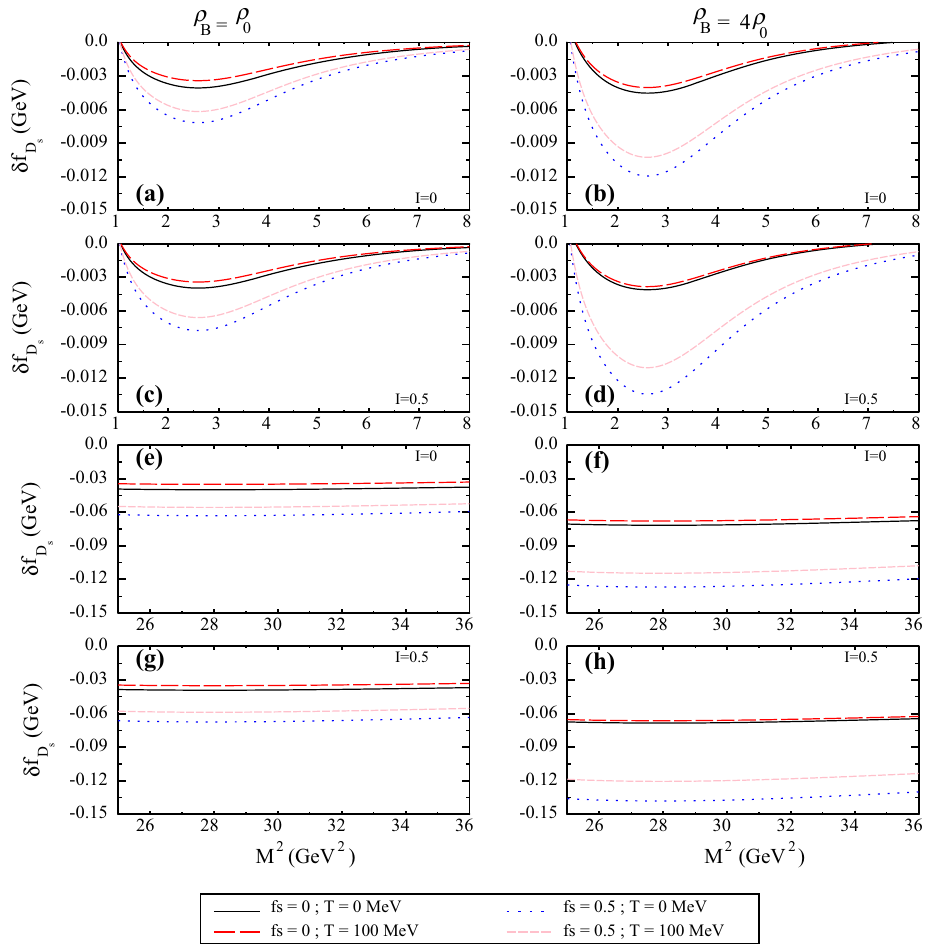
for isospin asymmetric parameters I = 0 and 0 . 5, temperatures T = 0 and 100 MeV and strangeness fractions f s = 0 and 0 . 5